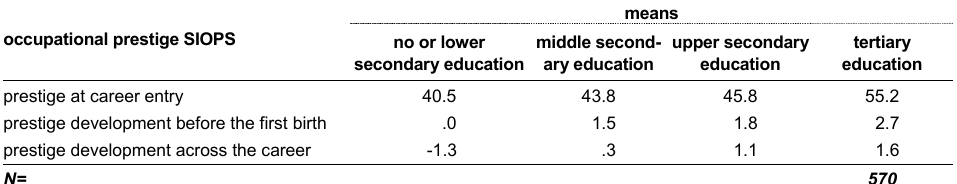
Table 4 : women’s occupational prestige and prestige development by educational group 13